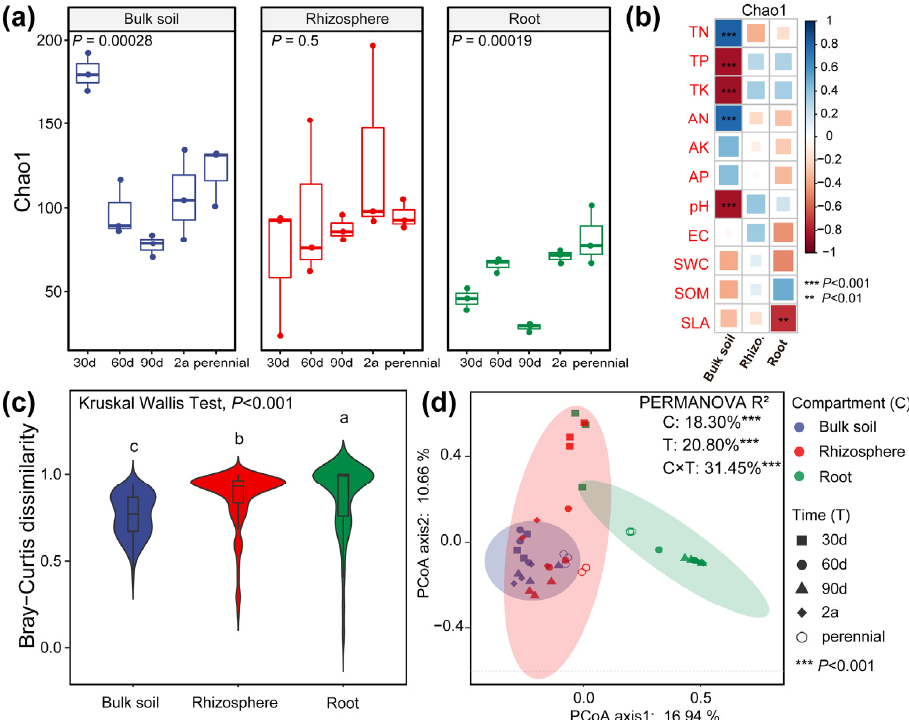
Figure 2. The α - and β -diversity of A. sparsifolia root-associated mycobiome. ( a ) Chao 1 of root-associated mycobiome in different host development times. ( b ) Pearson correlations between Chao 1 and soil properties. ***, p < 0.001; **, p < 0.01. All p values were corrected by FDR. ( c ) The Bray-Curtis dissimilarity at the ASV level among three root-associated compartments. Letters indicate significant differences according to the Kruskal Wallis test. ( d ) Principal coordinate analysis (PCoA) in combination with permutational analysis of variance (PERMANOVA). Ellipses indicate a 95% confidence interval. ***, p < 0.001. Abbreviations: 30 d, 30 days old; 60 d, 60 days old; 90 d, 90 days old; 2 a, 2 years old; perennial, over 3 years old. TN, total nitrogen (g/kg); TP, total phosphorus (g/kg); TK, total potassium (g/kg); AN, available nitrogen (mg/kg); AP, available P (mg/kg); AK, available potassium (mg/kg); EC, electrical conductivity mS/cm); SWC, soil water content; SOM, soil organic matter (g/kg); SLA, specific leaf area (cm 2 /g). C × T, interaction between